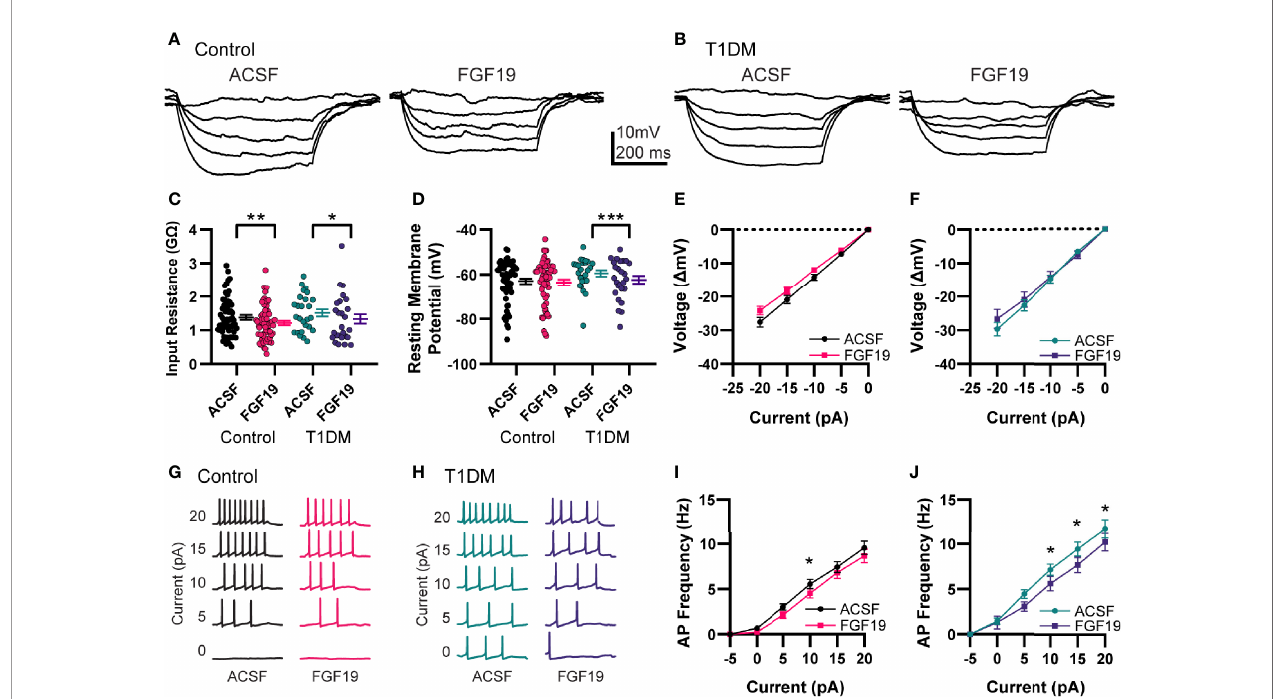
FIGURE 2 | FGF19 produces mixed effects on intrinsic excitability of NTS neurons. Representative current step recordings in current clamp mode from (A) control and (B) T1DM mice. (C) FGF19 signi fi cantly decreased mean input resistance in both control (n = 60; **p < 0.01) and T1DM mice (n = 26; *p < 0.05). (D) FGF19 did not alter mean resting membrane potential in control mice (n = 60; p > 0.05) but signi fi cantly hyperpolarized mean RMP in T1DM mice (n = 26; ***p < 0.001). (E) Averaged current-voltage relationship in seen control mice (n = 60). (F) Averaged current-voltage relationship seen in T1DM mice (n = 26). Representative traces showing action potential response to positive current injections in control (G) and T1DM mice (H) . (I) Averaged action potential frequency response to positive current injections in control mice (n = 60; p < 0.05). (J) Averaged action potential frequency response to positive current injections in T1DM mice (n = 26; p < 0.05). For all panels, * indicates p < 0.05; ** indicates p < 0.01, *** indicates p < 0.001. Repeated measures generalized linear mixed model analysis used for all analyses. No pharmacological blockers were included for these